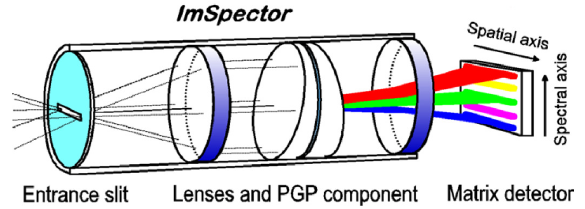
Figure 1. The principle of imaging spectrograph ImSpector (Lawrence et